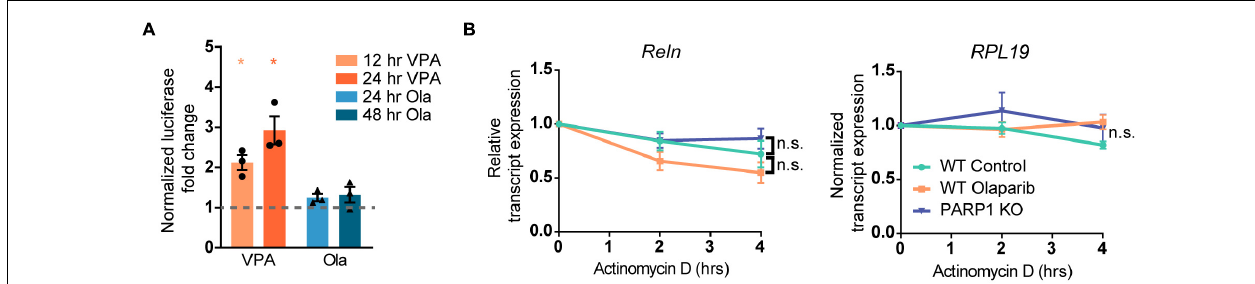
FIGURE 7 | Poly (ADP-ribose) polymerase 1 loss of function does not alter the activity of the Reln promoter or the stability of the Reln transcript. (A) NPCs transfected with plasmids expressing the putative Reln promoter (2600 base pairs upstream of the transcription start site) upstream of firefly luciferase did not show increased luciferase activity after treatment with Olaparib (Ola, 100 nM) for 24 or 48 h. Valproic Acid (VPA) is a known positive regulator of the Reln transcript and was used as a positive control. * p < 0.05 by one-way ANOVA. (B) PARP1 KO or PARP1 inhibition with Olaparib (100 nM) does not alter the stability of the Reln transcript. RNA polymerase II was inhibited by treatment with Actinomycin D (10 µ g/mL) for 2 and 4 h and transcript levels were assessed. Reln was normalized to RPL19 expression, which did not decline over 4 h. No significant difference was observed between slopes for any of the groups.